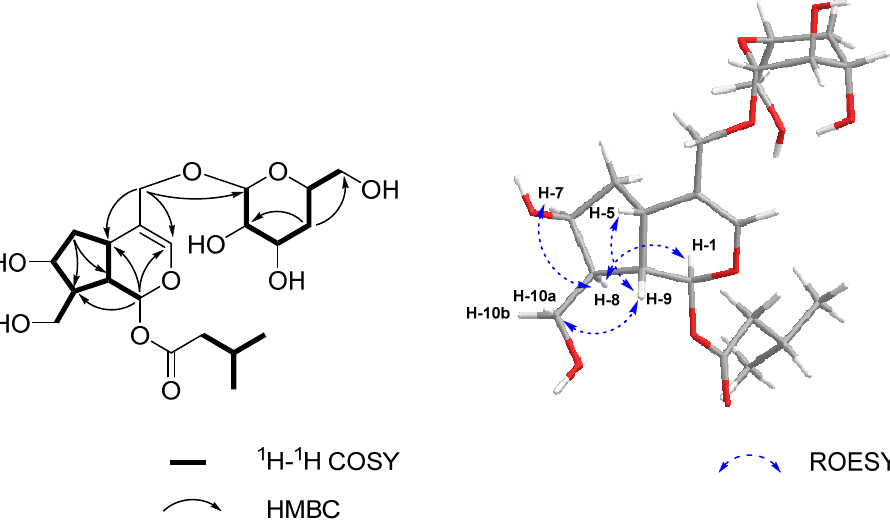
Figure 3. Key 1 H- 1 H COSY, HMBC, and ROESY correlations for compound 2 .